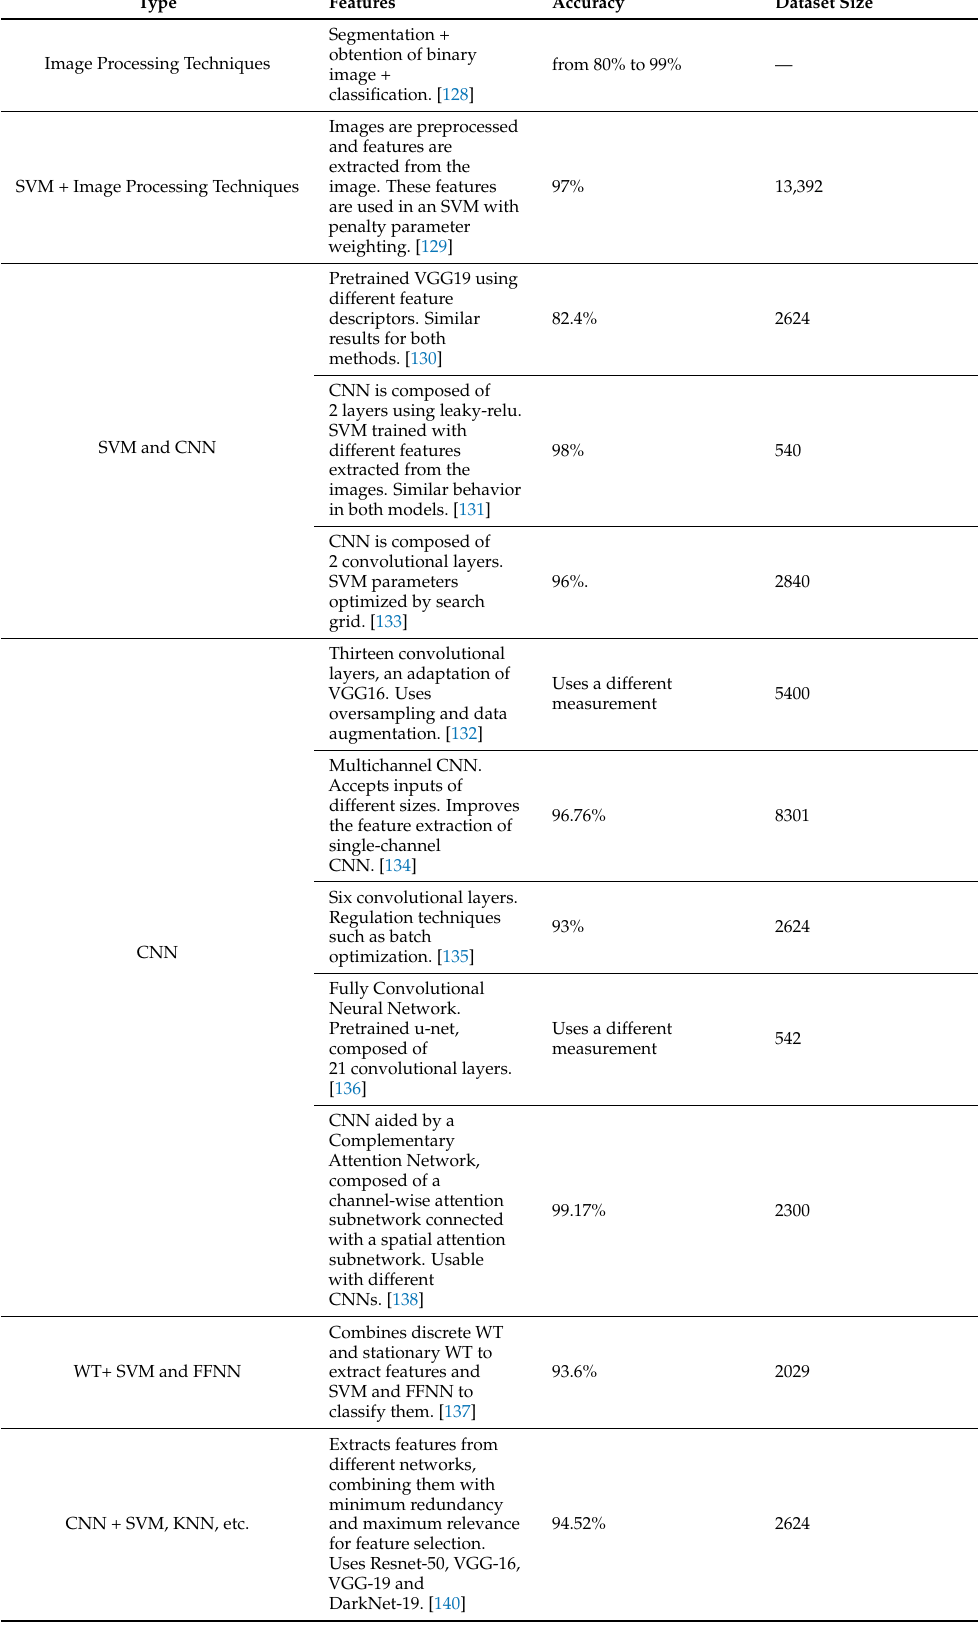
Table 7. Models for detection of